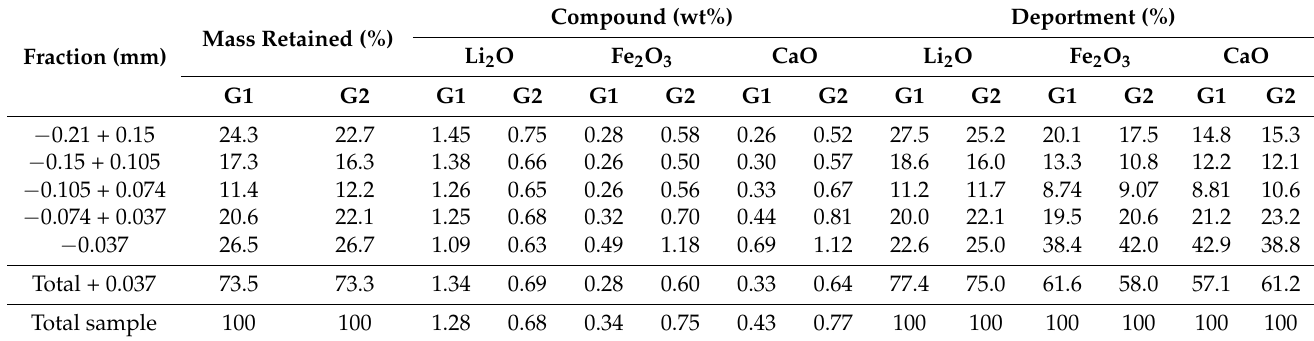
Table 5. Mass retained (%), compound content (wt%), and deportment (%) by size fraction. Compound (wt%) Mass Retained (%) Fraction (mm) Fraction